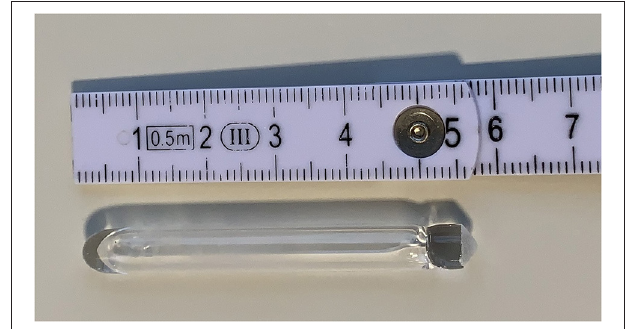
FIGURE 1 | Typical example of a vacuum-sealed quartz ampoule ready for irradiation. The target material is deposited at the bottom of the ampoule (left side